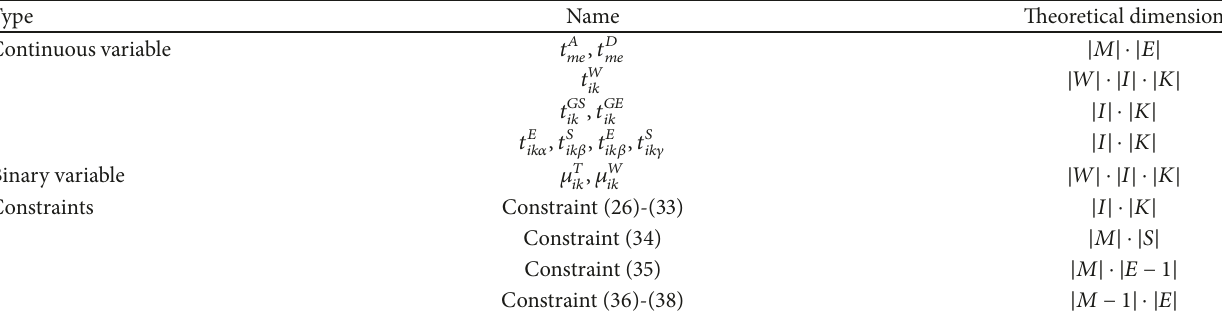
Table 3: Numbers of variables and constraints in the